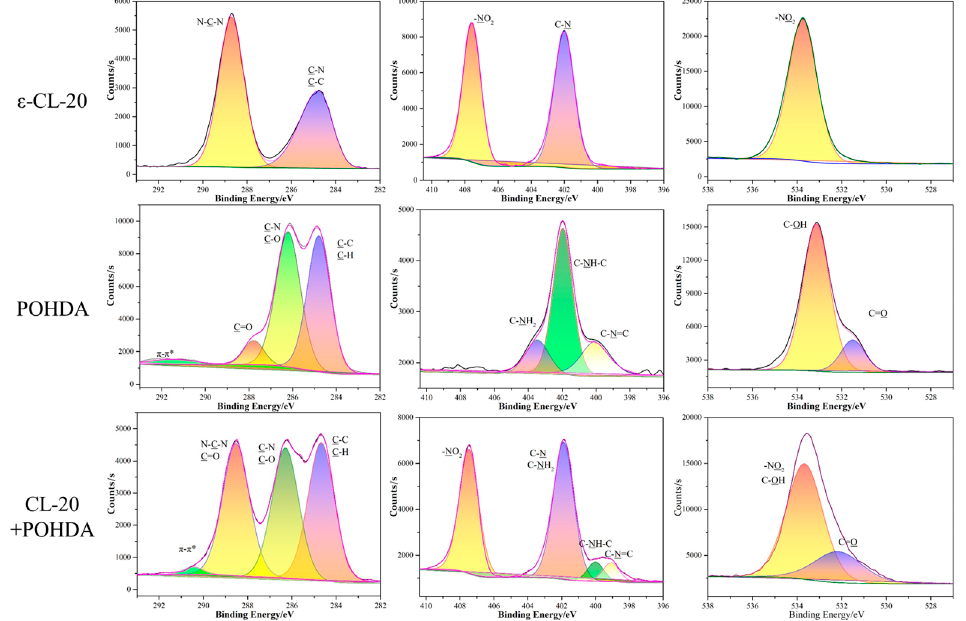
Figure 7. XPS spectra for ε‐ CL ‐ 20, POHDA, and ε‐ CL ‐ 20/POHDA core ‐ shell composites.